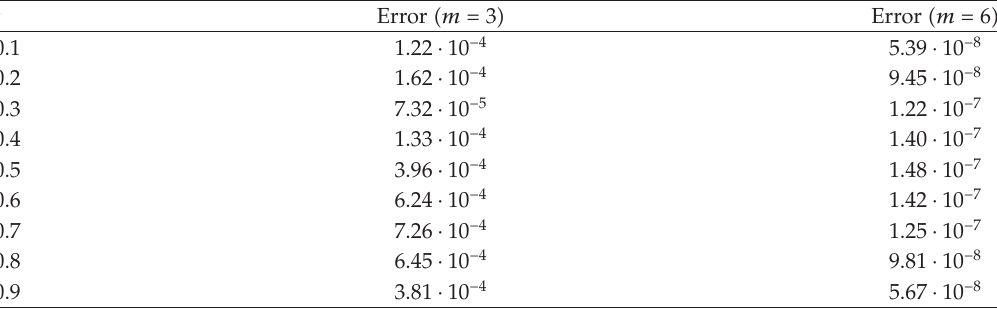
Table 2: Problem (cid:4) 5.3 (cid:5) —Example 5.2.